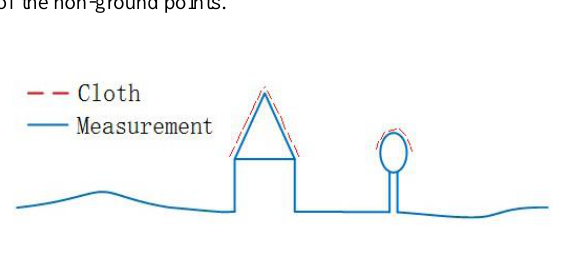
Figure 2. An overview of the cloth simulation algorithm(not inverting the point cloud)